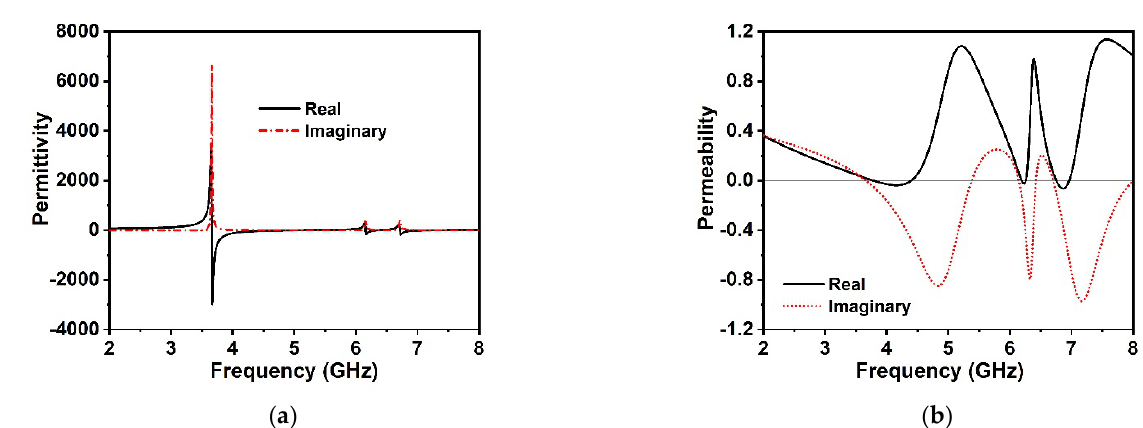
Figure 3. ( a ) Effective permittivity values and ( b ) effective permeability values with the DNG region of the proposed MM.